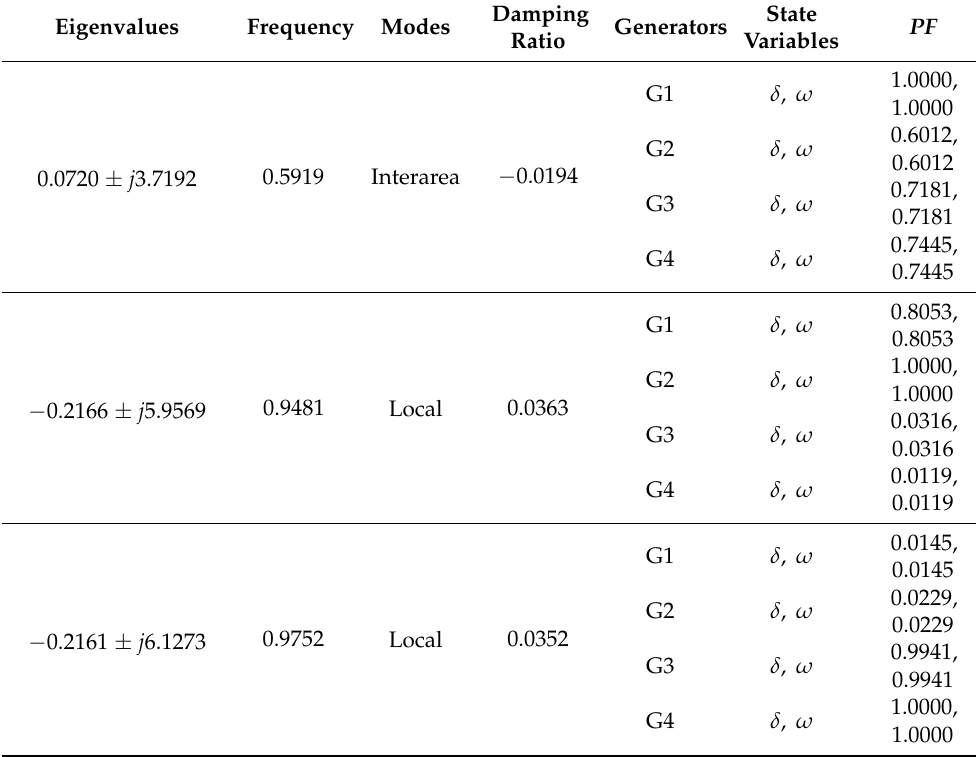
Table 11. Test system electromechanical modes and participation factor analysis.